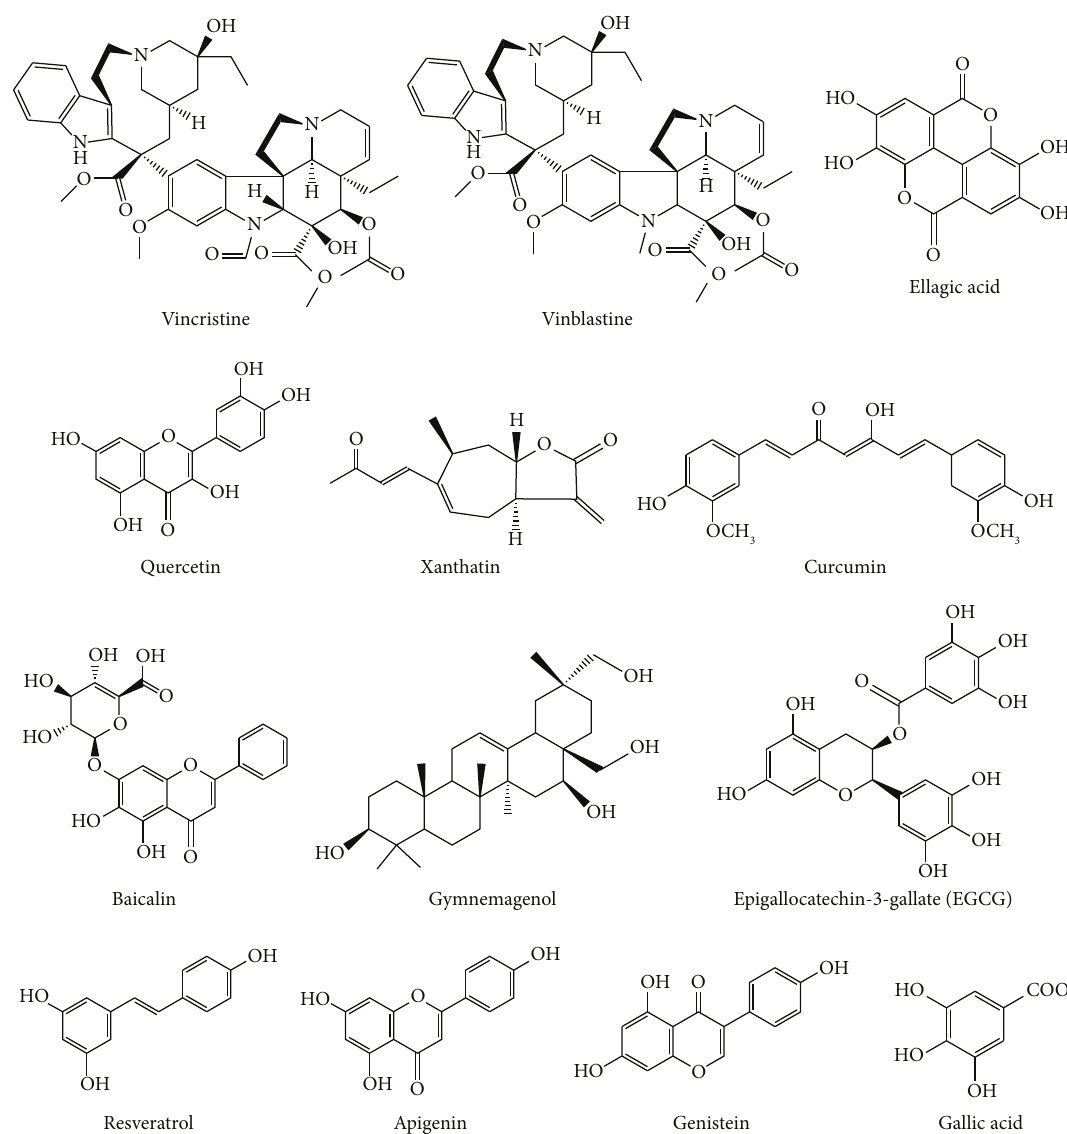
Figure 1: Structures of some lead anticancer